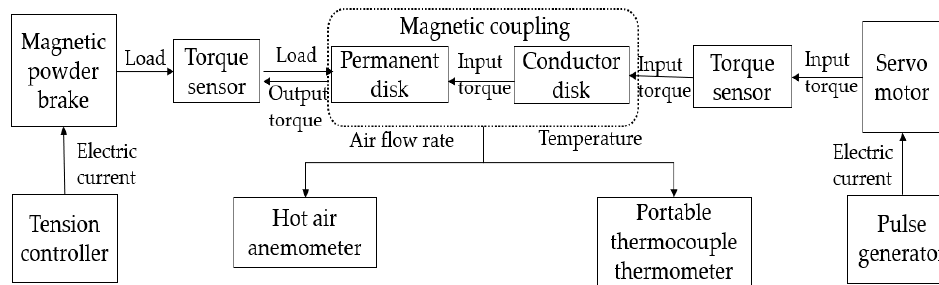
Figure 9. Test platform data flow diagram.